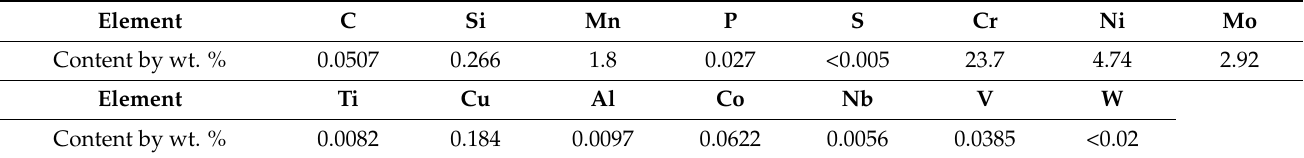
Table 8. Chemical composition of the samples made of X2CrNiMoN22-5-3 steel (according to